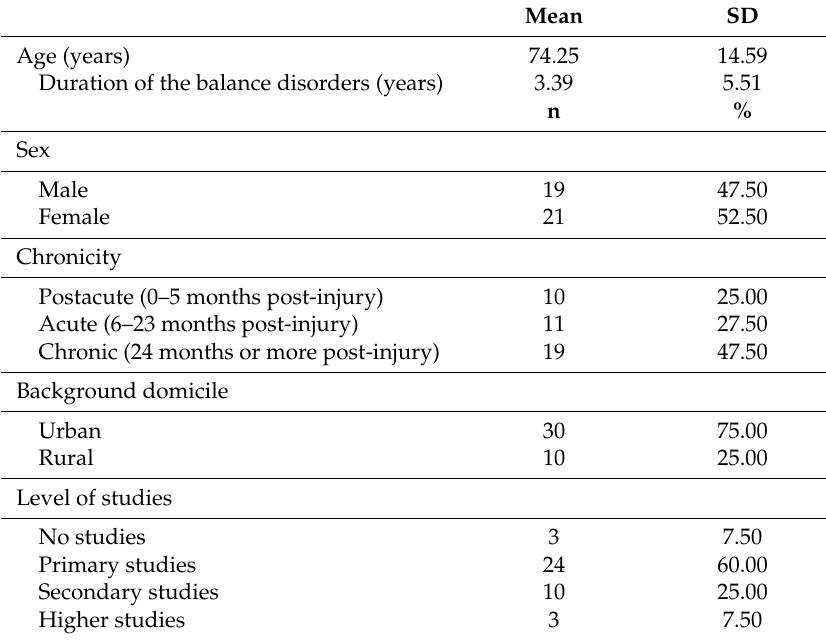
Table 2. Characteristics of the participants.